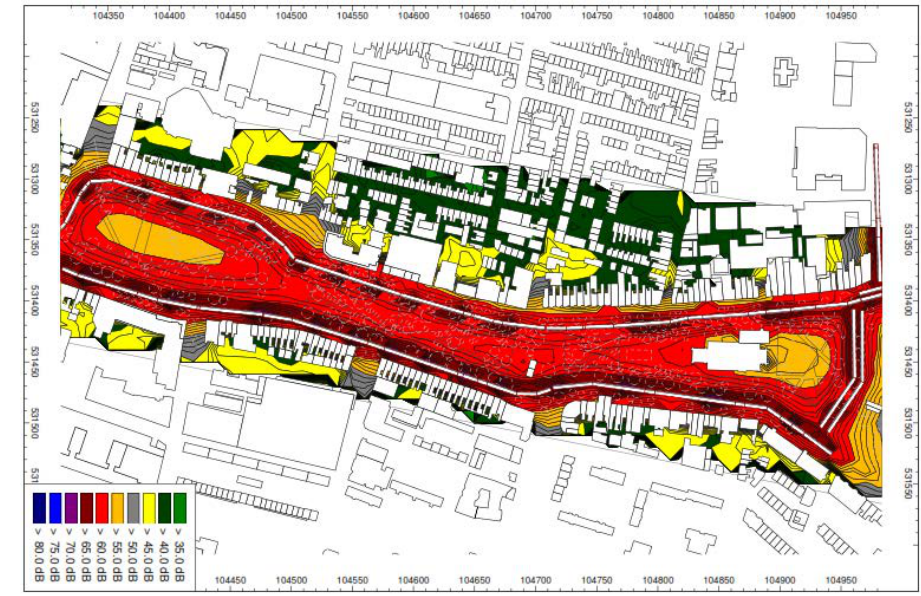
Figure 3: Noise map of the simulated scenario with a one-meter barrier one meter off the roads (L day